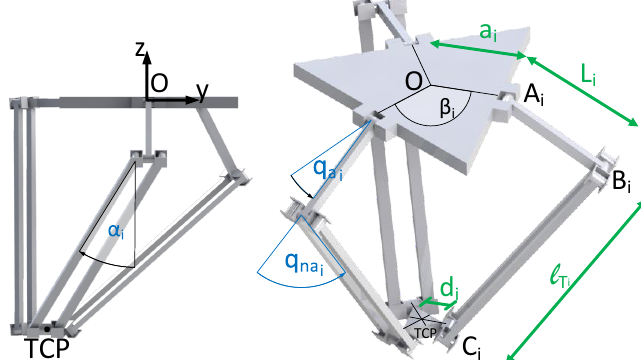
Figure 4. Robot schematic with the most important parameters and variables.